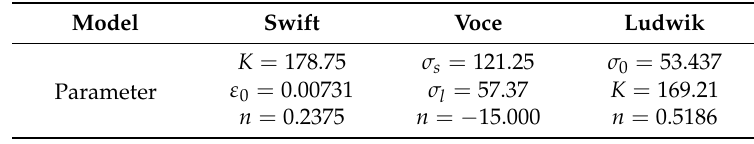
Table 3. Parameter values for each constitutive models.